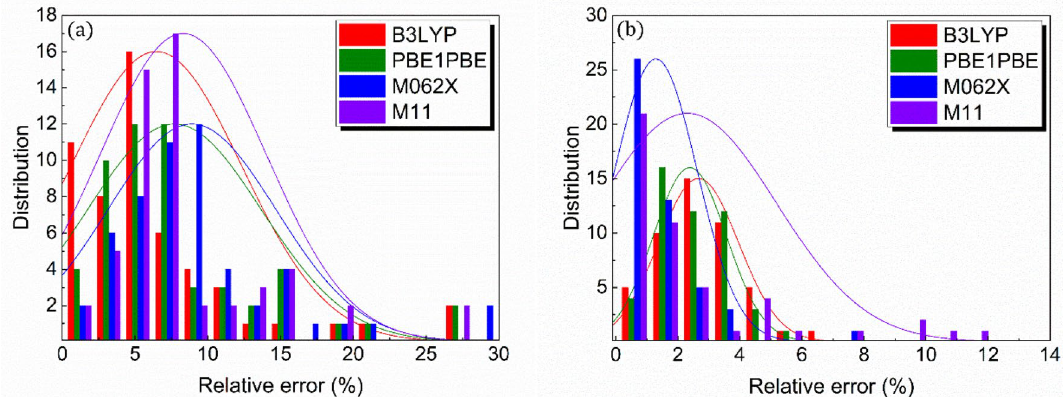
Figure 4. Relative errors for polarizability and ionization energy. Errors of the DFT-computed values relative to their experimental values for ( a ) polarizability and ( b ) ionization